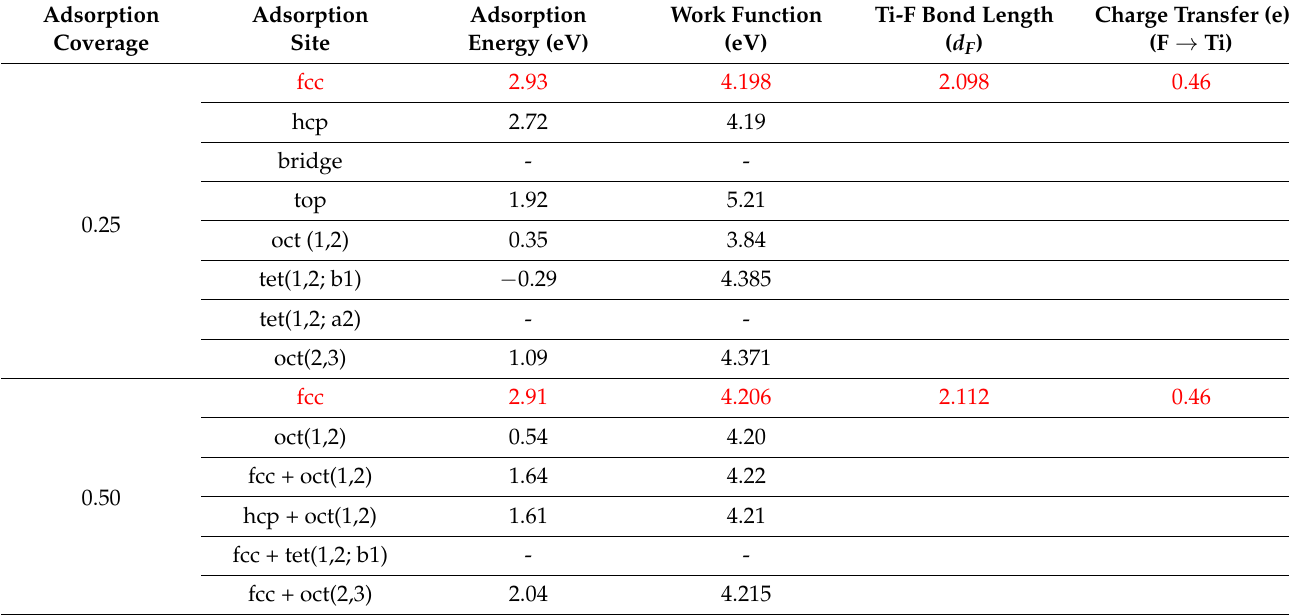
Figure 1. ( a ) Top view of the Ti(0001) surface with F atoms occupying all fcc sites. ( b , c ) Perspective views of the F adsorption sites; oct( i,j ) denotes an octahedral site between the i th and ( i + 1)th layers, and tet( i ,:a j (or b i )) denotes a tetrahedral site located directly below the i th layer. The work function of the clean surface was 4.47 eV, consistent with experimentally determined values (4.45–4.60 eV) [27] and previous DFT results (4.45 ± 0.01 eV) [15,28]. and work functions, average F-Ti bond lengths, and charge Mulliken populations for the most stable adsorption position (Table 1). Table 1. Average adsorption energies per F atom at the various adsorption sites of the Ti(0001) surface, along with the work function, average Ti-F bond length, and transferred charge. The work function of the clean Ti(0001) surface is 4.47 eV.